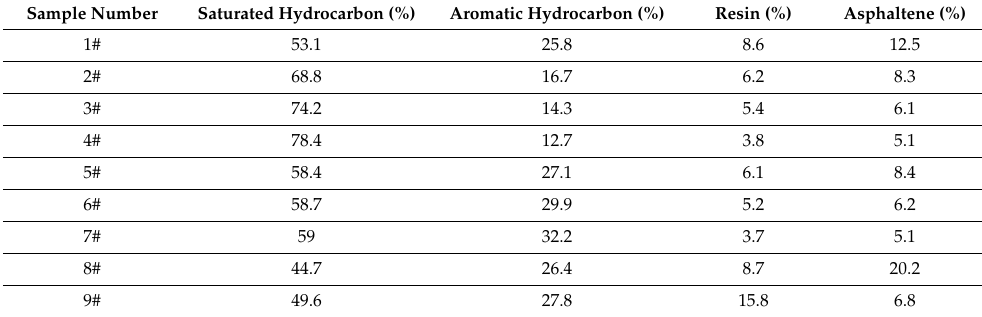
Table 3. Group components of different components in simulated oil.